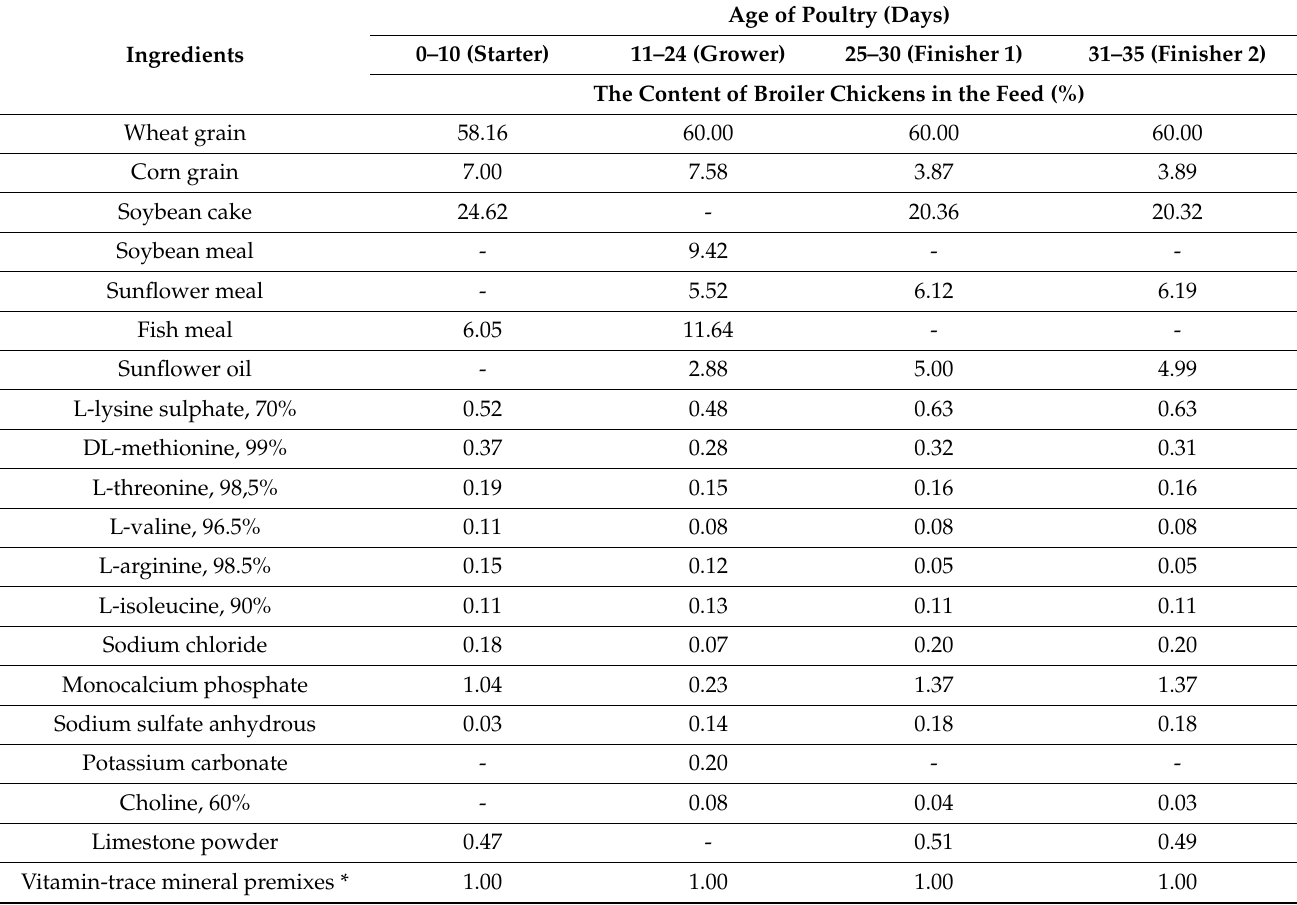
Table 2. The composition of feeds for broiler